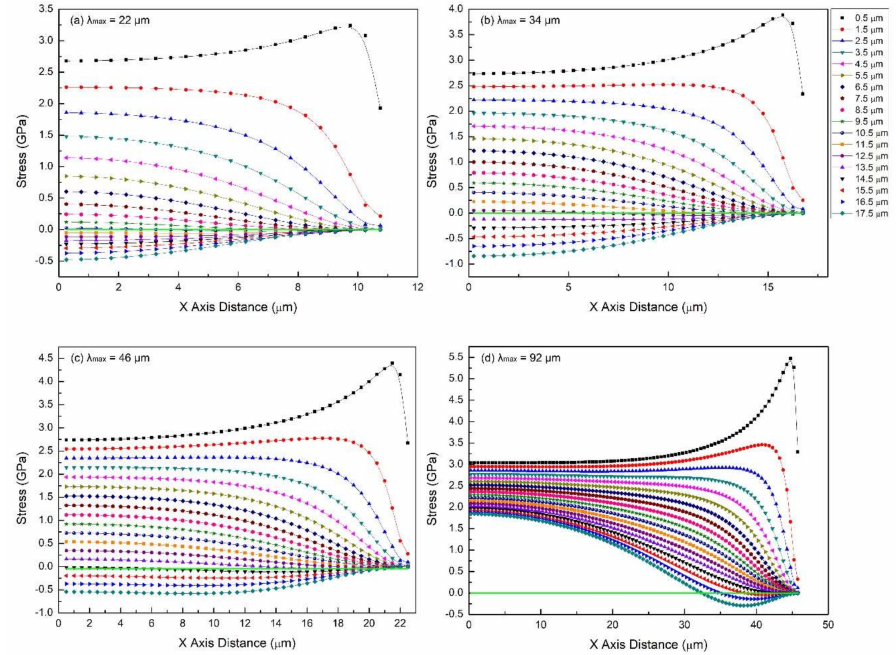
Figure 4. The in-plane stress distribution (dot-line plot) in films of different crack spacings for the case of the film/substrate system being tested in tension: ( a ) λ max = 22 µ m, ( b ) λ max = 34 µ m, ( c ) λ max = 45 µ m, ( d ) λ max = 92 µ m. Common features: E SS = 200 GPa, E PDC = 50 GPa, δ = 18 µ m, ε f =